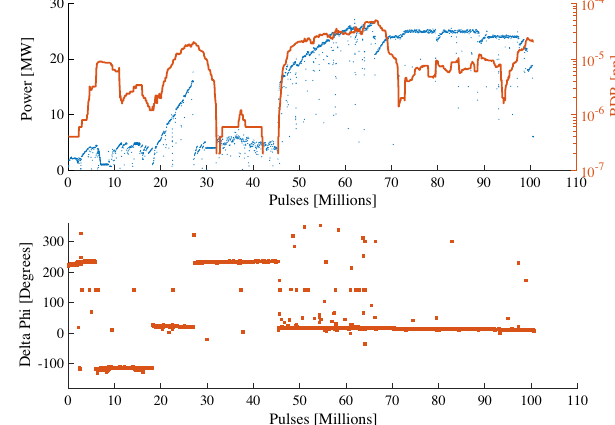
FIG. 31. Conditioning history and BDR (top) with phase difference between signals PEI1 and PEI2